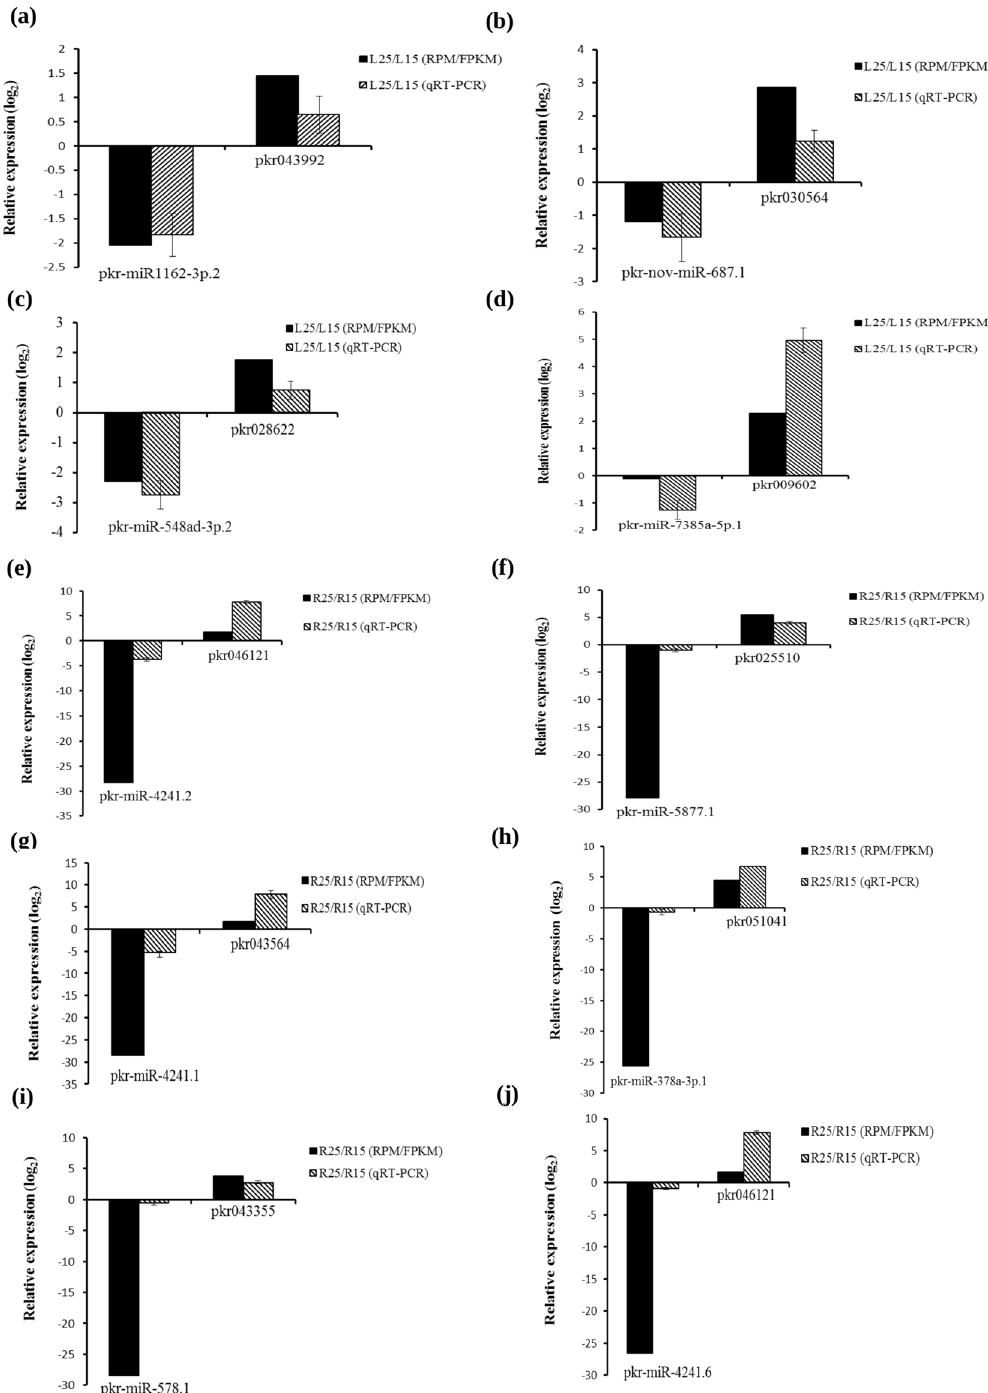
Figure 7. Relative expression of ten miRNAs and respective targets at 25 °C as compared to those at 15 °C based upon data obtained by reads per million (RPM) for miRNA and fragments per kilobase of exon per million fragments values (FPKM) for respective targets followed by validation using qRT-PCR ( a – j ). The relative expression values were log 2 transformed. Actin and 5.8 S rRNA were used as endogenous control to normalize the data for miRNA targets and miRNAs, respectively. Each value in the bar diagram represents mean of three independent biological replicates and error bars represent standard error of